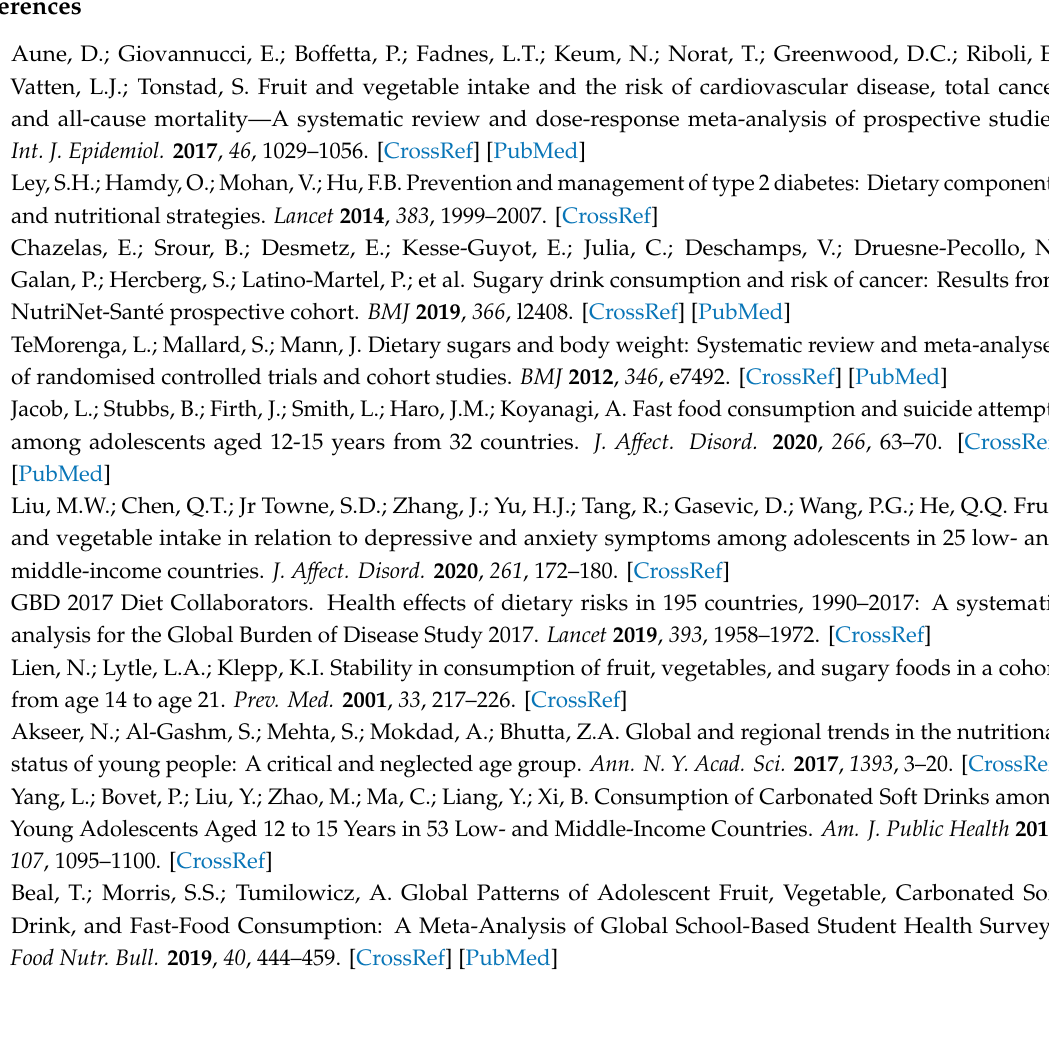
Figure S1: Study flowchart; Table S1: Subgroup analyses for number of unhealthy eating